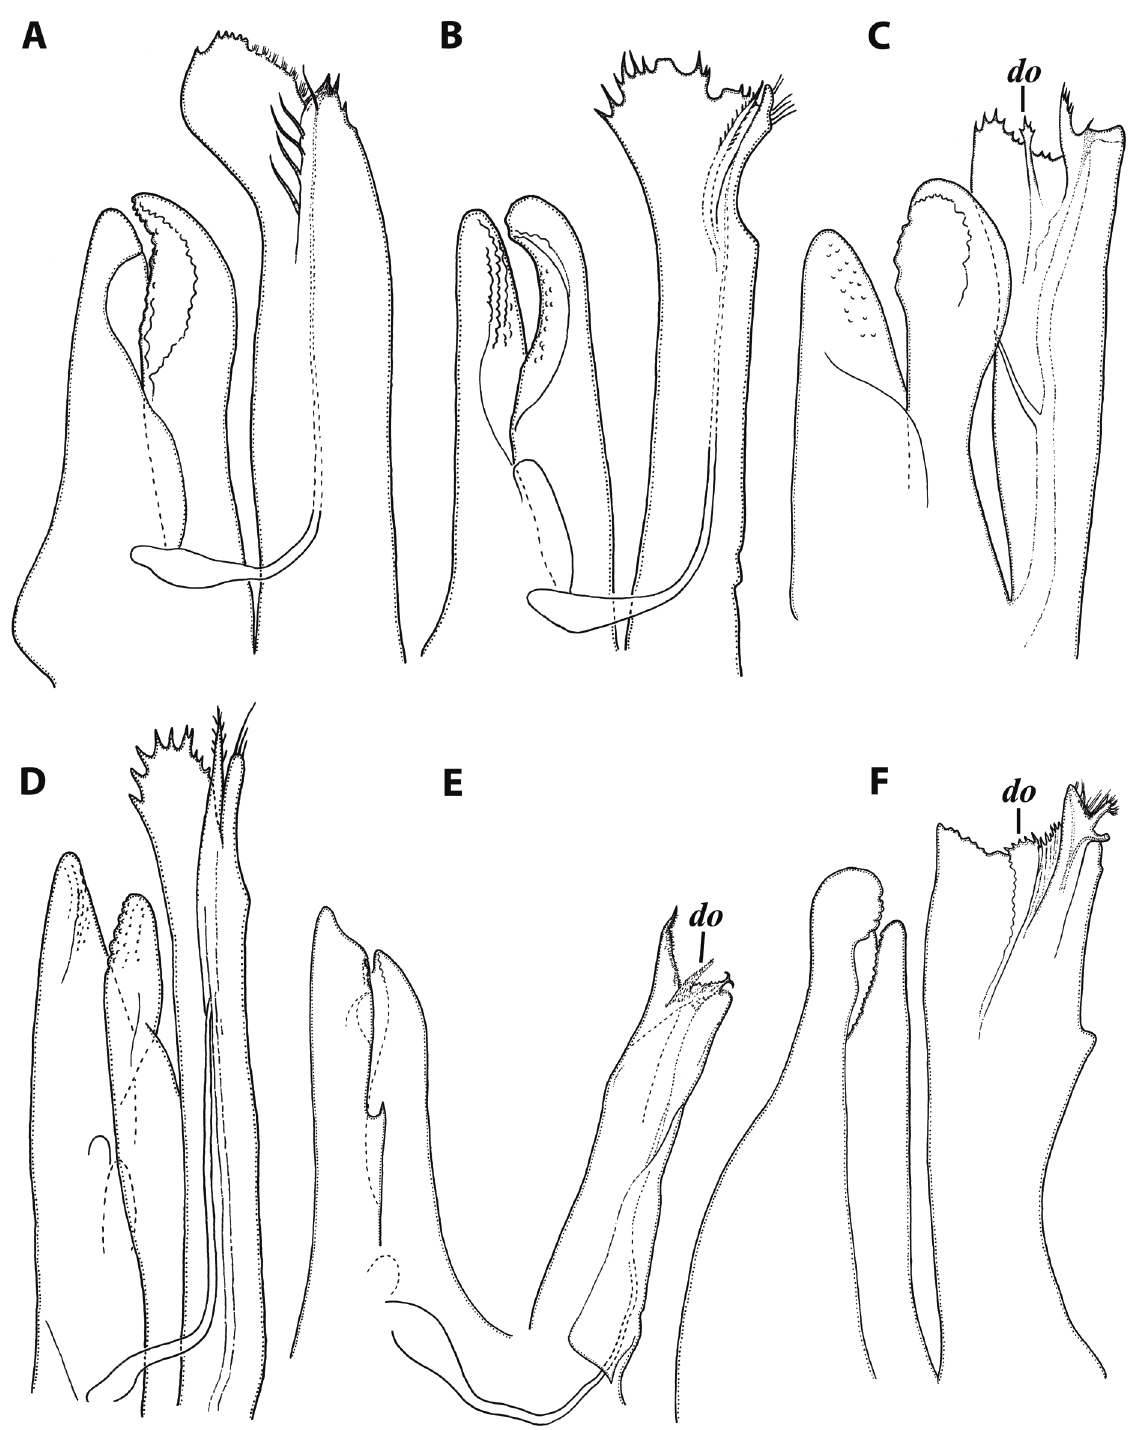
Fig. 10. Left gonopods of species of Stygiiulus stat. nov., mesal views. A . S. ausugi (Manfredi, 1953) comb. nov., topotype ♂ (NHMD). B . S. illyricus (Verhoeff, 1929) comb. nov., redrawn from Verhoeff (1929). C . S. insularis (Strasser, 1938) comb. nov., redrawn from Antić et al. (2018). D . S. maximus (Verhoeff, 1929) comb. nov., redrawn from Verhoeff (1930). E . S. seewaldi (Strasser, 1967) comb. nov., redrawn and modified from Strasser (1967). F . S. tobias (Berlese, 1886) comb. nov., ♂ from Grotta [Cave] del Subiolo (NHMD). Abbreviations: do = distal outgrowth of velum. Drawn not to